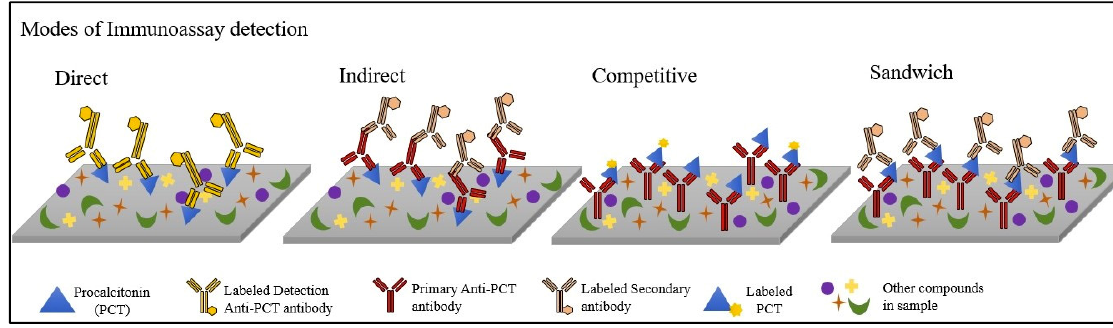
Figure 1. Schematic representation of various immunoassay formats.